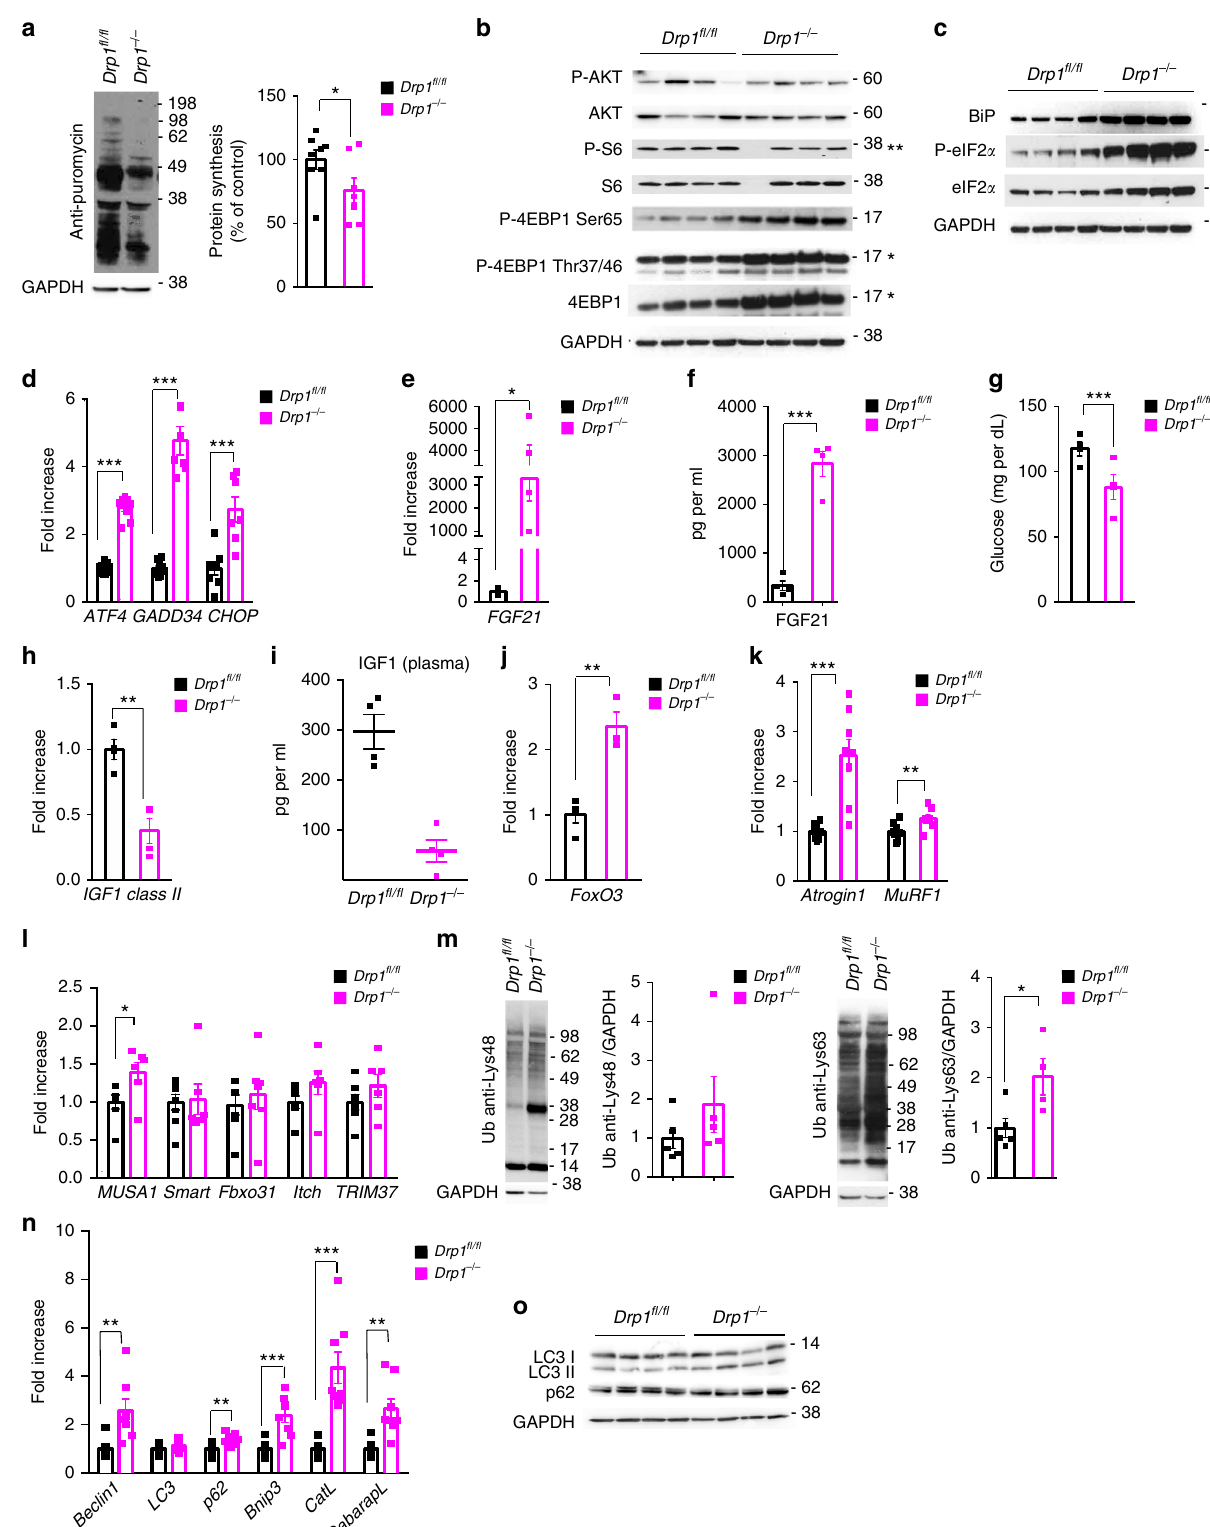
treatment in 5-month-old mice ef fi ciently reduced DRP1 protein in different muscles (Fig. 4a). Within 50 days from tamoxifen treatment, mice started to differ in body weight when compared with controls (Fig. 4b). The reduction of body weight was sec- ondary to important decrease of muscle mass. Skeletal